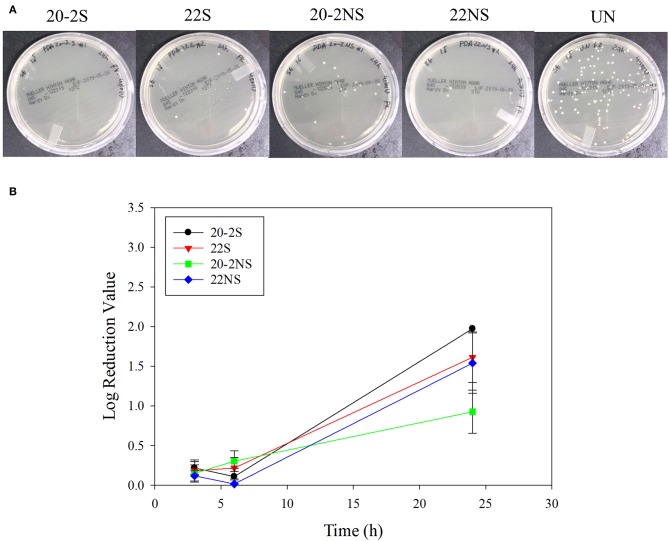
Photograph of the test plates for S. epi colonies exposed to PDA-coated meshes and the uncoated mesh control after 24 h (A). Log reduction values for E. coli colonies incubated with the PDA-coated meshes, which is normalized by the number of colonies formed by the bacteria exposed to the uncoated mesh (B). Data are shown as mean ± standard deviation of three independent samples.